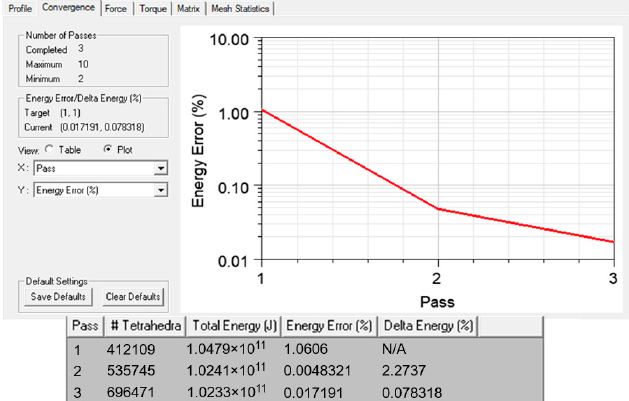
Figure 6. Convergence graph and iterated mesh elements.